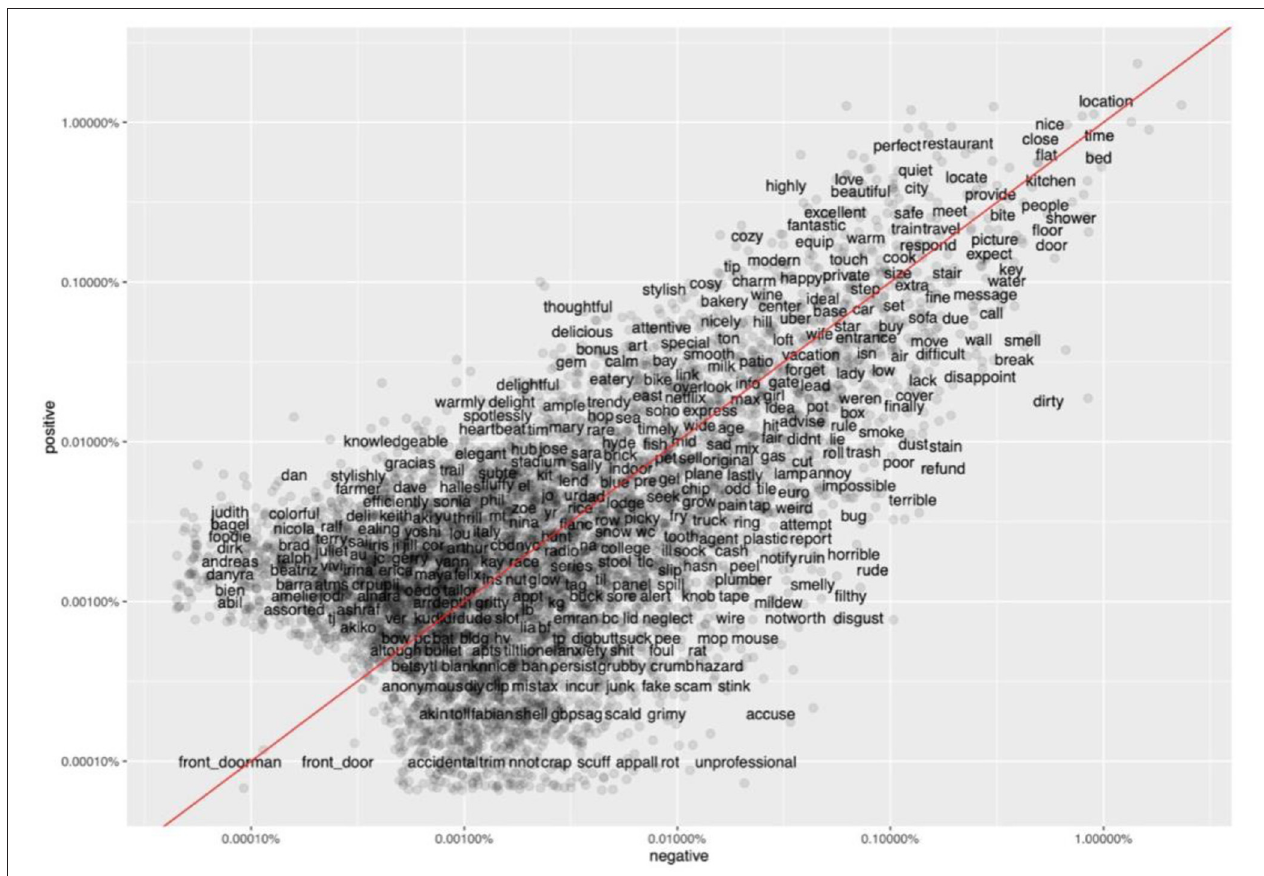
FIGURE 4 | Comparison of frequent terms in positive and negative reviews. Source: created by the